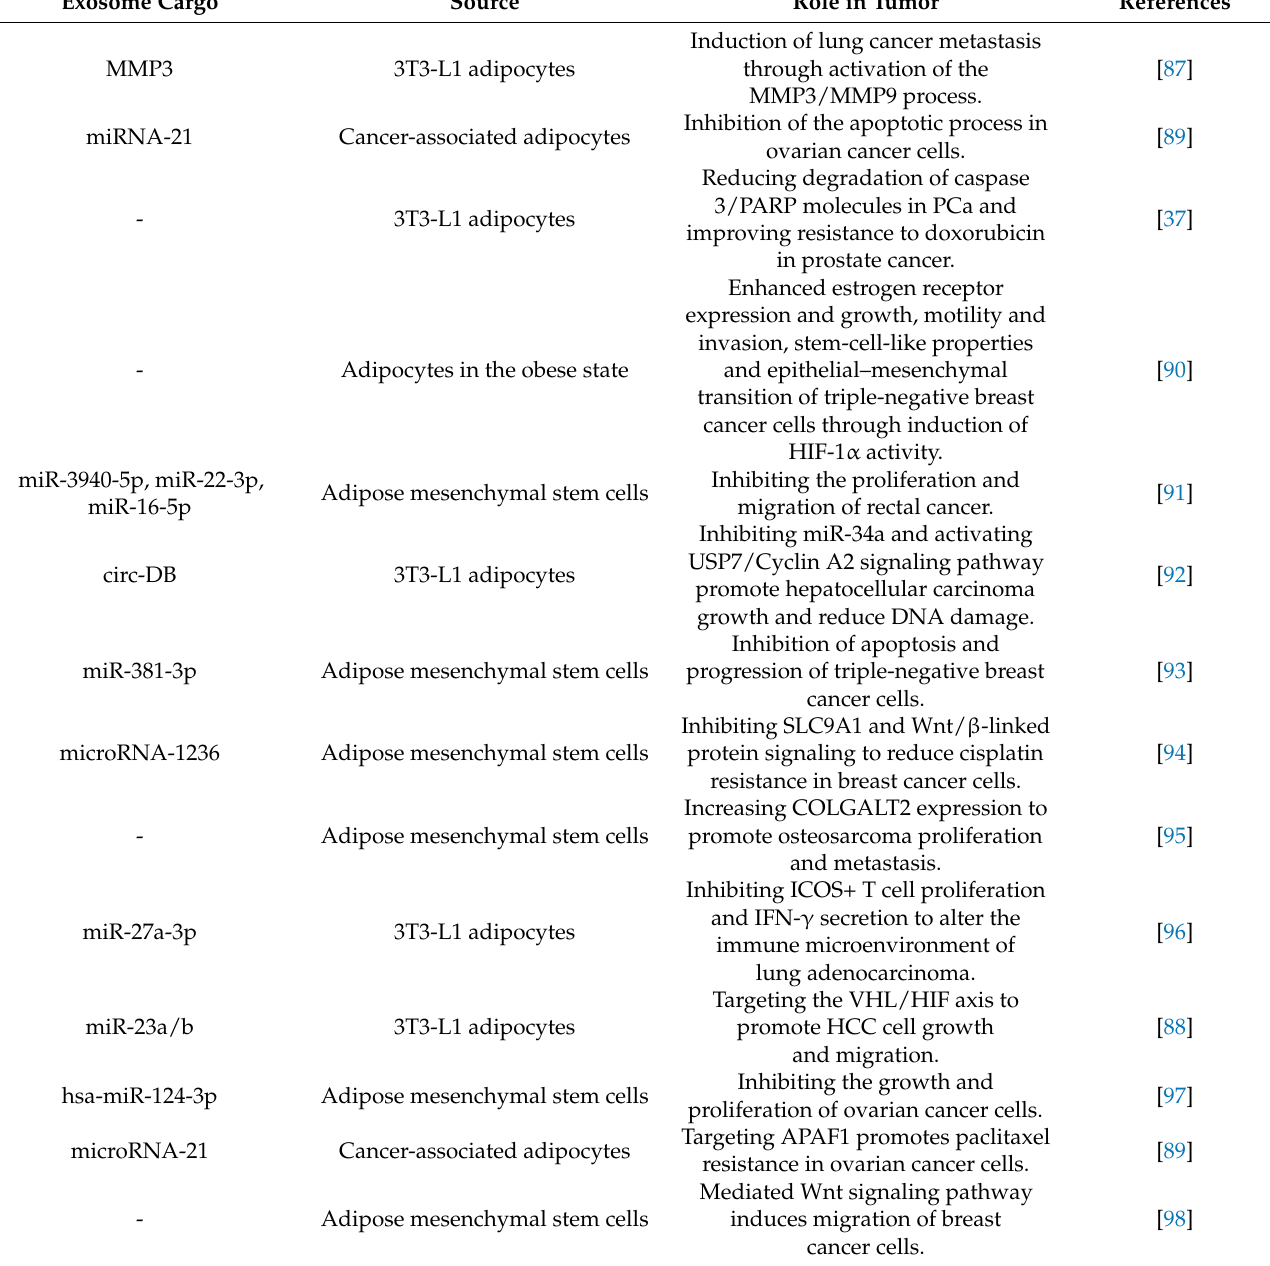
Table 2. Tumorigenic effects of adipocyte-derived